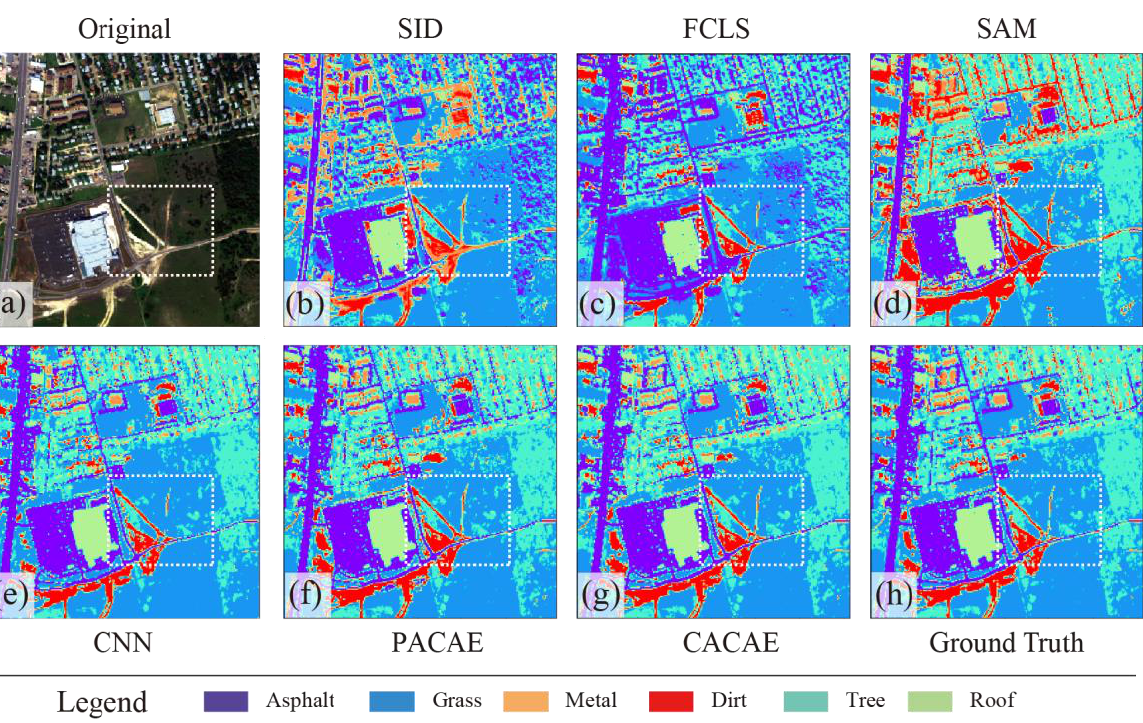
Figure 10. The classification results for the Urban dataset by different methods. ( a ) Original HSI in RGB format; ( b ) SID; ( c ) FCLS; ( d ) SAM; ( e ) CNN; ( f ) PACAE; ( g ) CACAE; ( h ) Ground Truth.